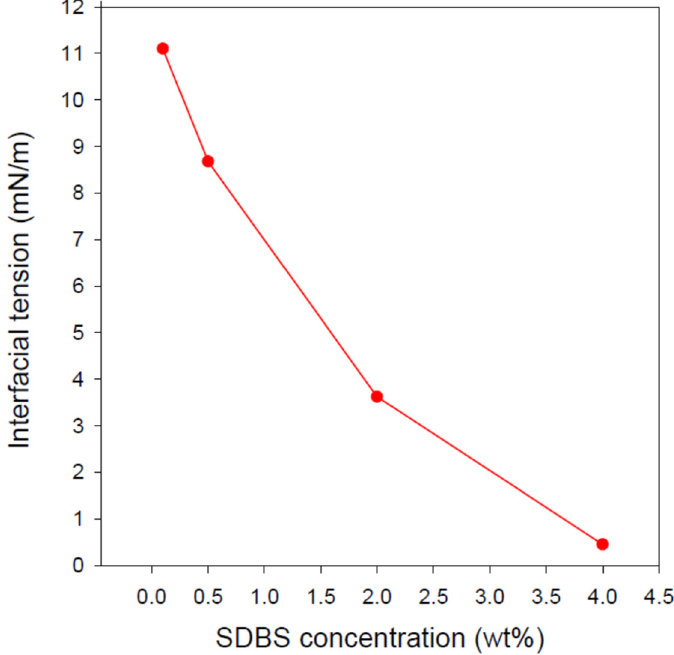
Figure 3. Effect of SDBS concentration on the equilibrium IFT (taken after 1 h) of the nanoemulsions. Due to the opacity of crude oil, diesel was used instead as the surrounding oil phase during the IFT measurements.